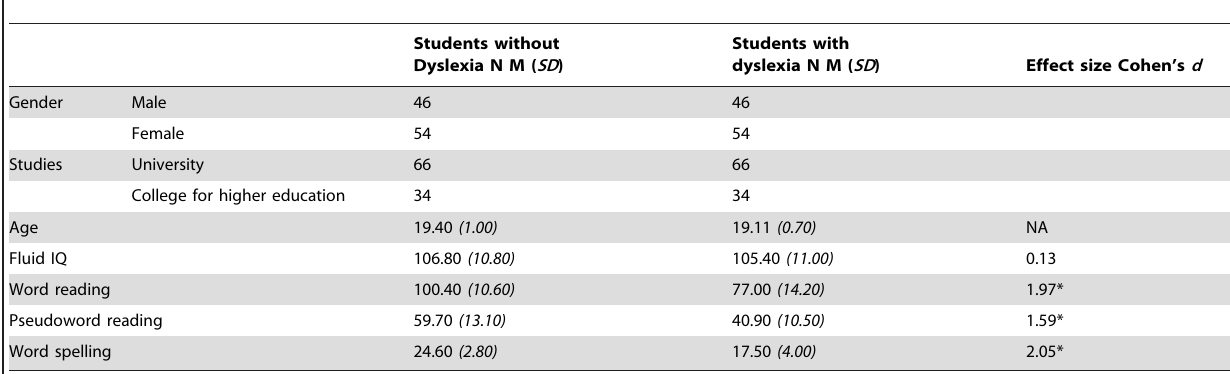
Table 1. General Information About the Student Groups With and Without